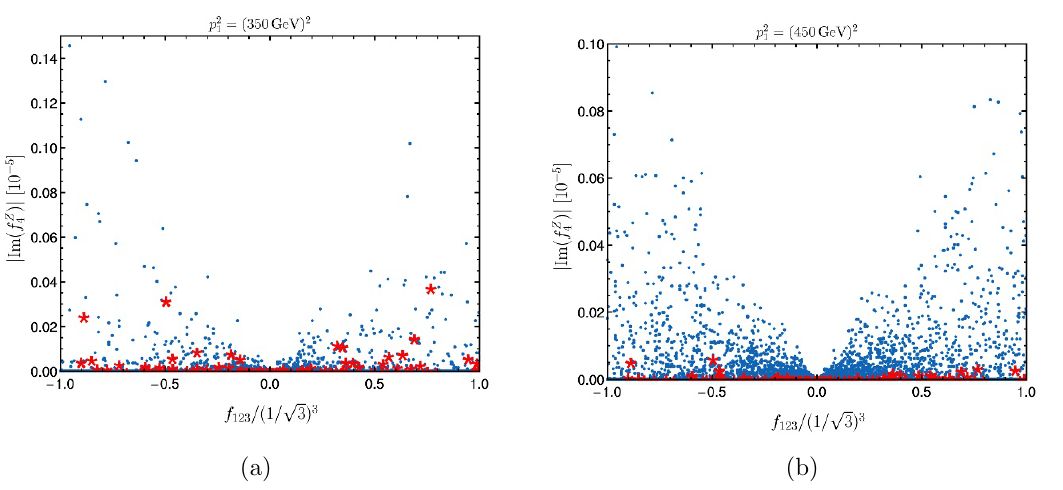
Figure 5. Scatter plots for the imaginary part of f Z as a function of the combined Z -scalars 4 coupling f 123 of eq. (4.6), divided by its maximum possible value of (1 = p 3) 3 . In (a) results for p 2 = (350 GeV) 2 ; in (b), p 2 = (450 GeV) 2 . In red, points for which the masses of all the dark scalars 1 are smaller than 200 GeV, m h < 200 GeV ( i = 1 ; 2 ; 3). i